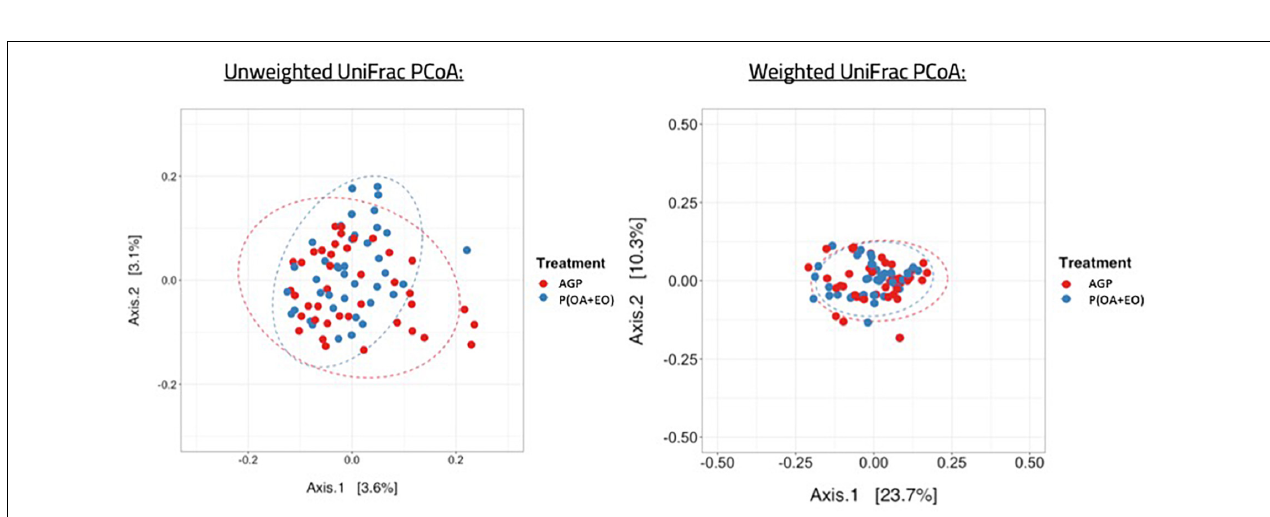
FIGURE 2 | Alpha diversity indices of the cecal microbiota of broiler chickens supplemented with antibiotic growth promoter (AGP) or protected organic acids (OA) and essential oils (EO) [P(OA + EO)] raised under field conditions. Values are means of 40 replicates. PD, phylogenetic diversity (Observed species: P = 0.048; Chao1: P = 0.048; Shannon, InvSimpson, and PD whole tree: P > 0.05).